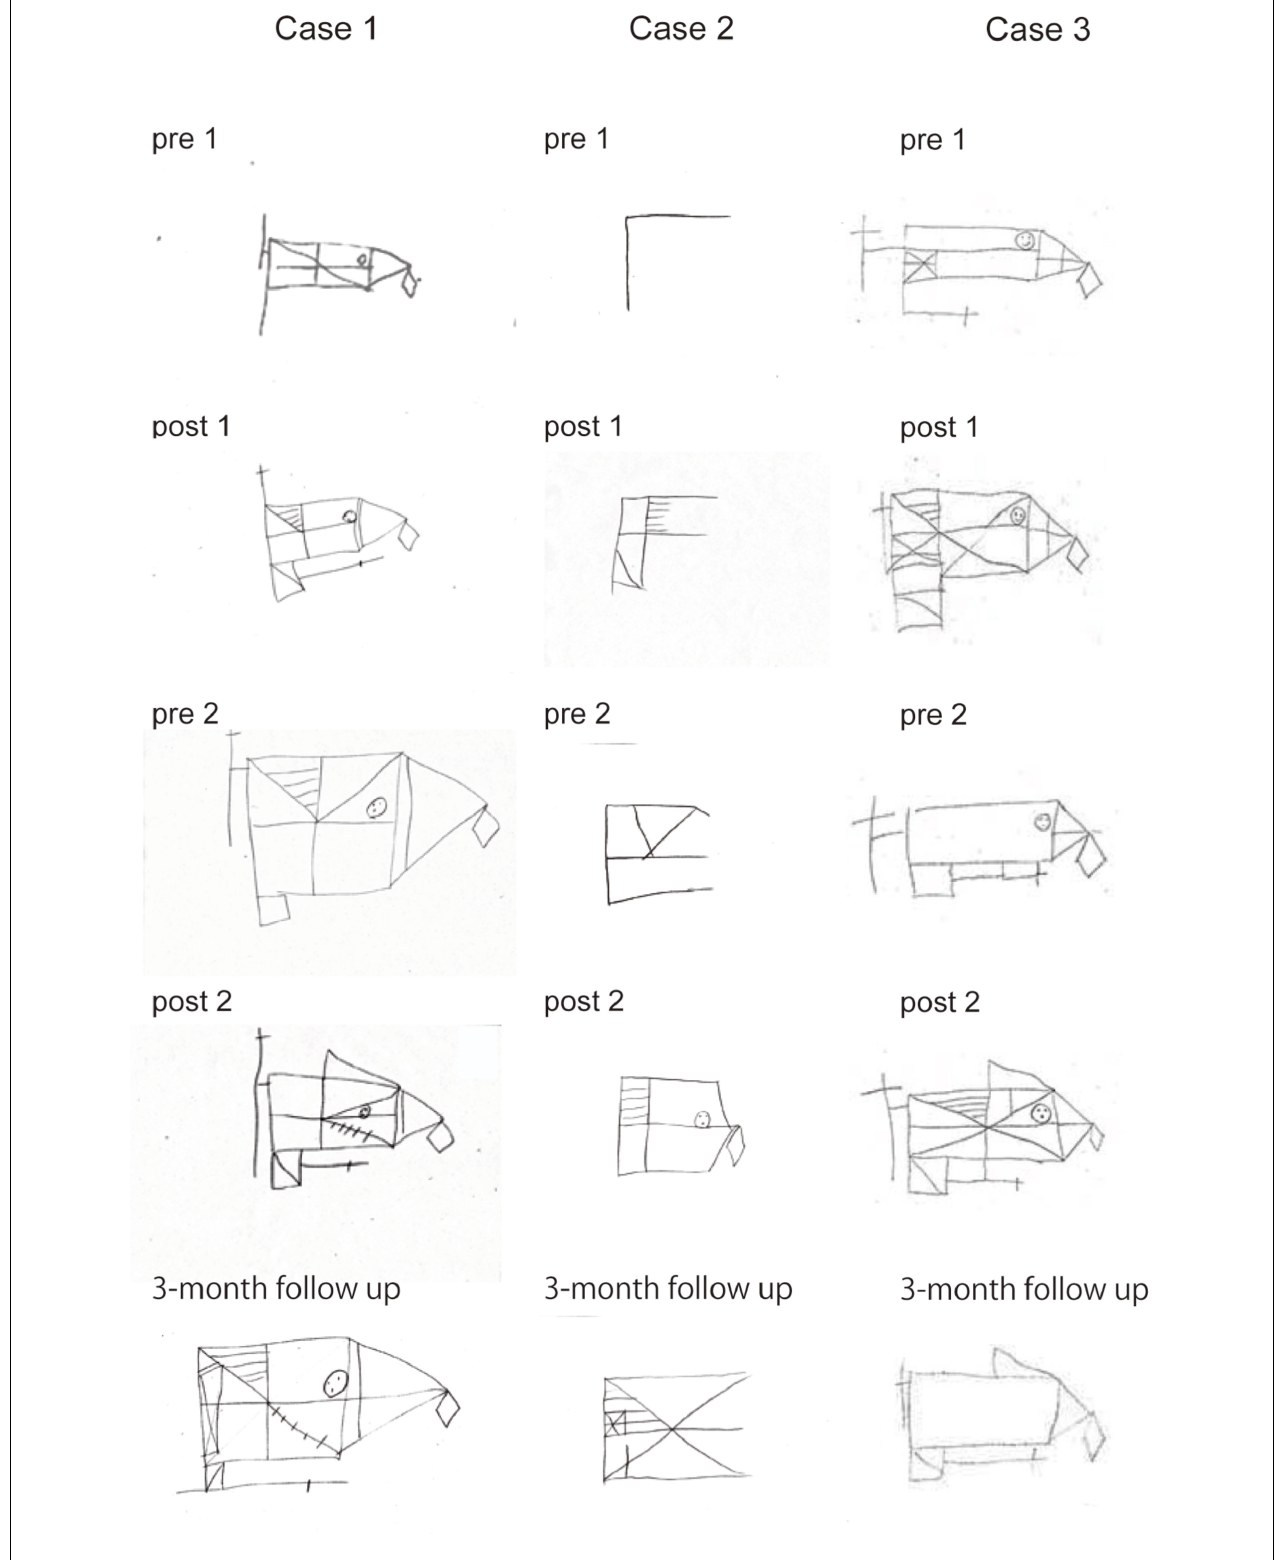
FIGURE 6 | Drawing samples of the Rey–Osterrieth complex figure recall test in three SFA-treated patients.